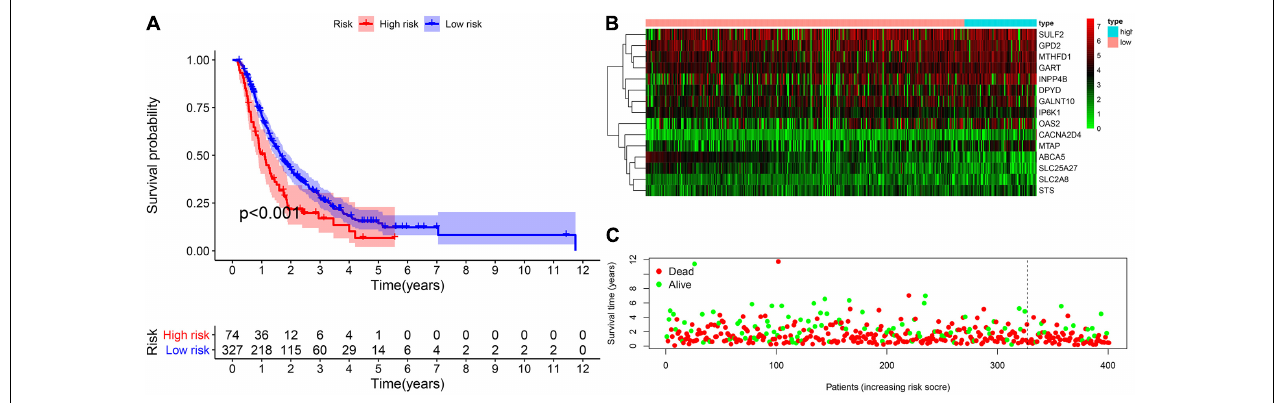
FIGURE 7 | External validation of the prognostic model. (A) The Kaplan–Meier curve of overall survival. (B,C) The heatmap of the 15 genes and the survival status of patients.